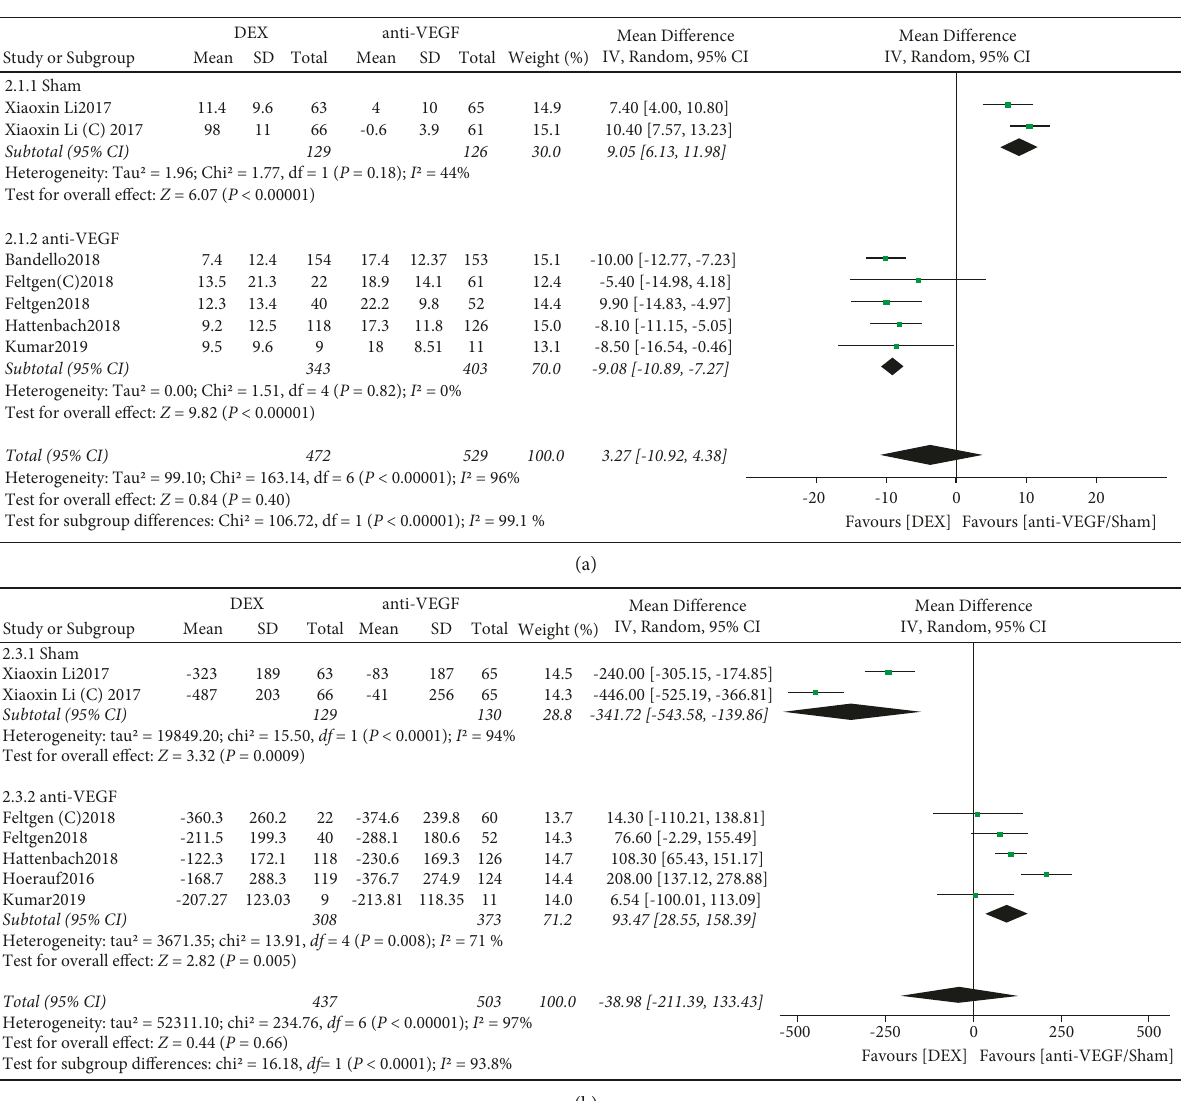
Figure 4: (a) Forest plot of BCVA for RVO-ME. (b) Forest plot of CRT for